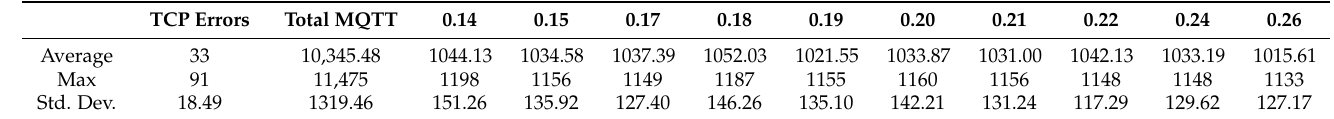
Table 2. Server MQTT packet load per minute in the 10 sensor node scenario.